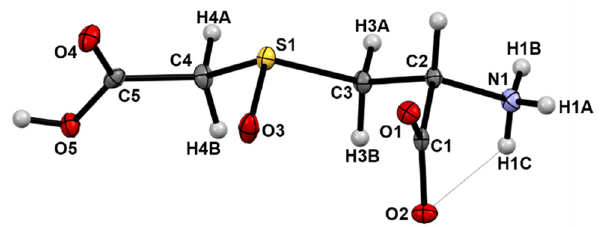
Figure 2. Atom numbering and displacement ellipsoids at 50% probability level for (2 R ,4 S )- S -carboxymethylcysteine sulfoxide crystallized in the monoclinic space group. A suspected intramolecular hydrogen bond is shown as a thin dotted line.